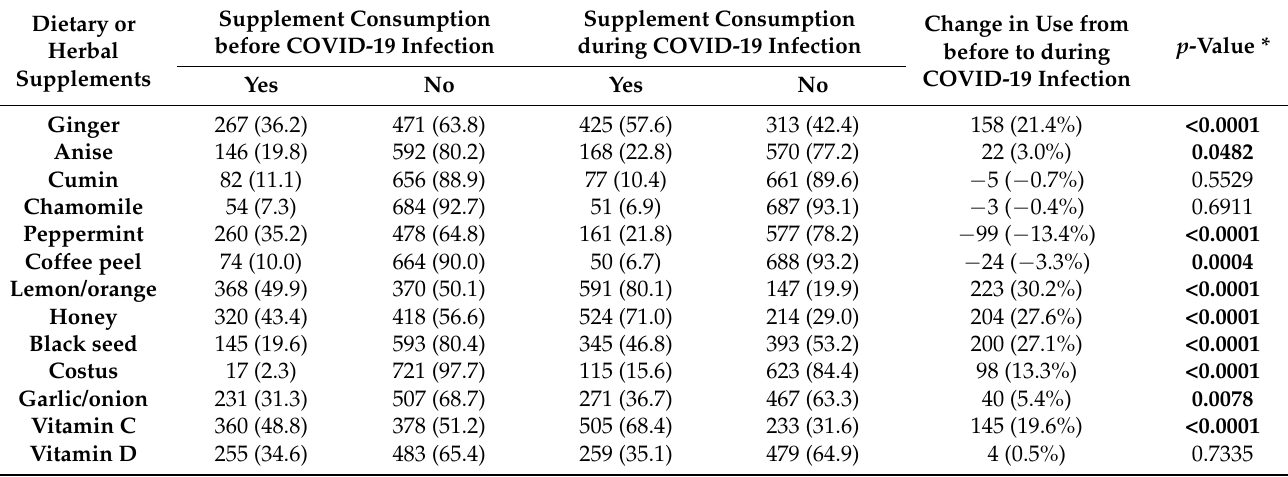
Table 2. Change in patients’ use of dietary or herbal supplements before and during infection with COVID-19. Dietary or